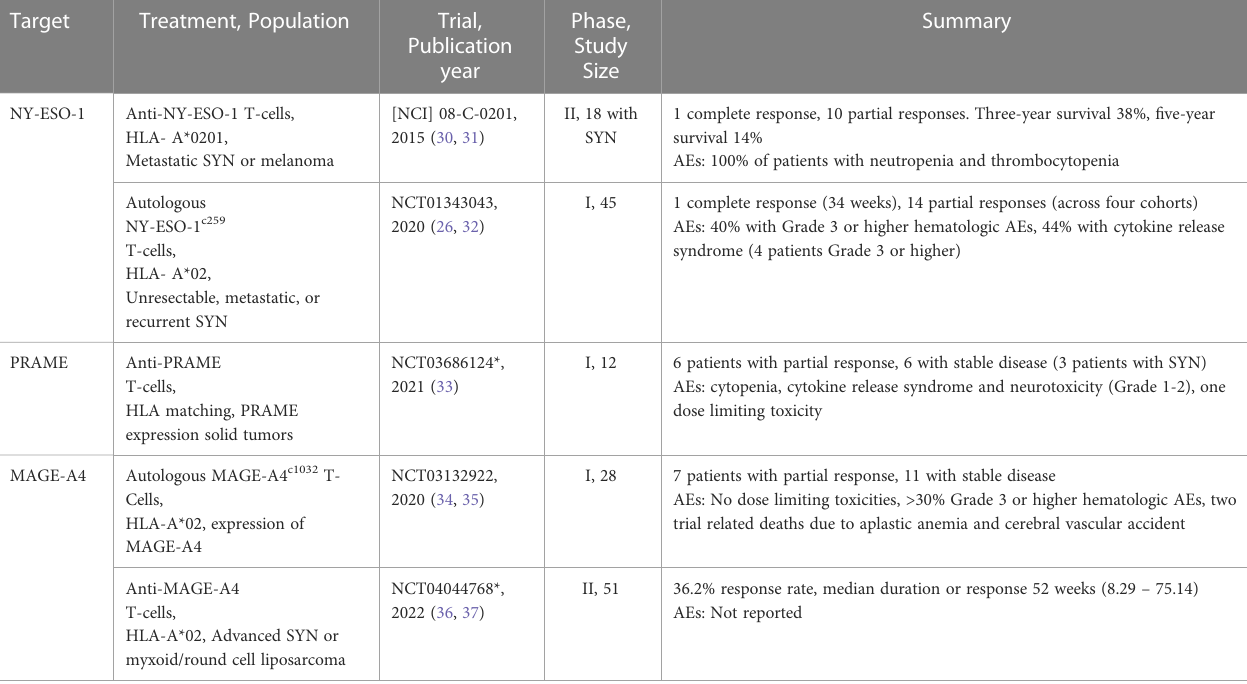
TABLE 1 Clinical trials completed or with preliminary results for treatment of SYN.